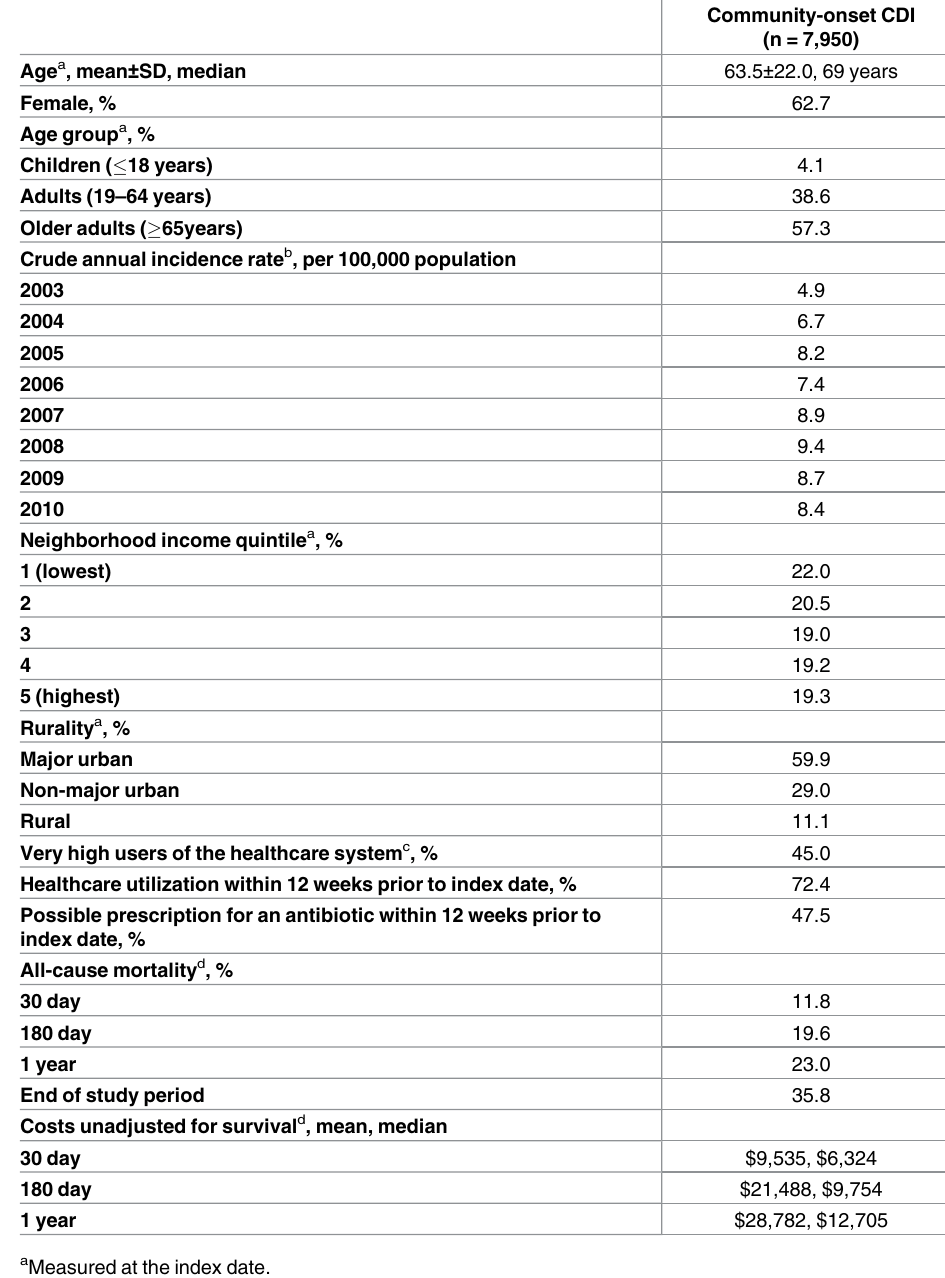
Table 1. Selected characteristics prior to